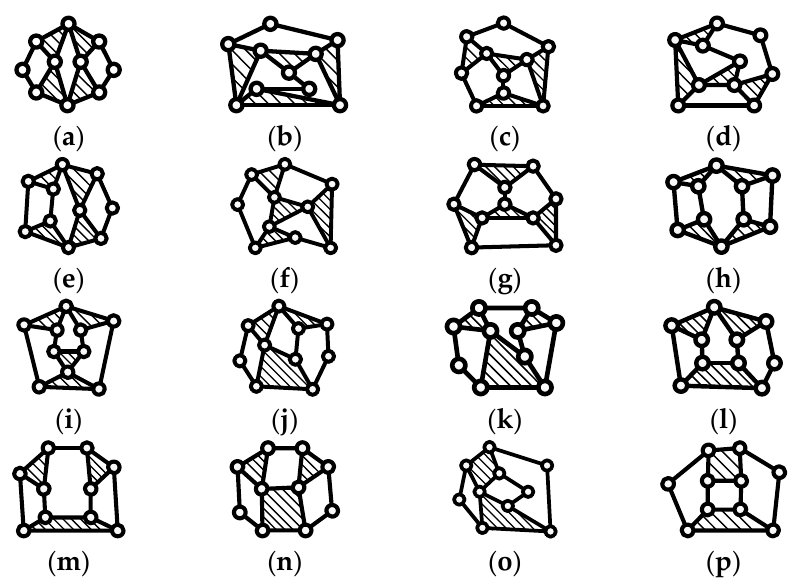
Figure 3. Kinematical chain of closed-chain eight-bar mechanism with a single DOF.